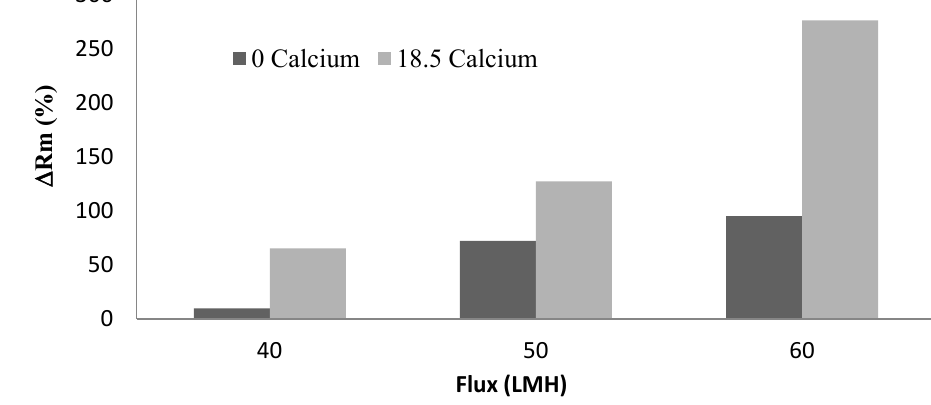
Figure 8. Effect of operational flux on irreversible resistance.